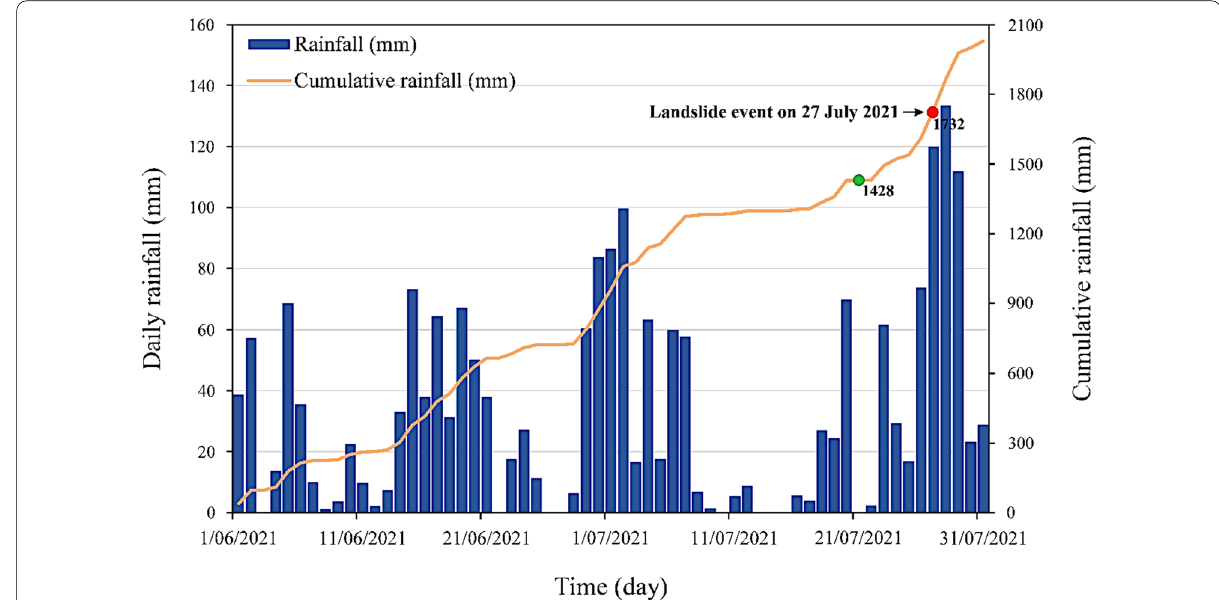
Fig. 6 Daily and cumulative rainfall from June to July 2021. The red dot indicates the 27 July 2021 landslide event. Data Source Bangladesh Meteorological Department; https:// bmd. gov.